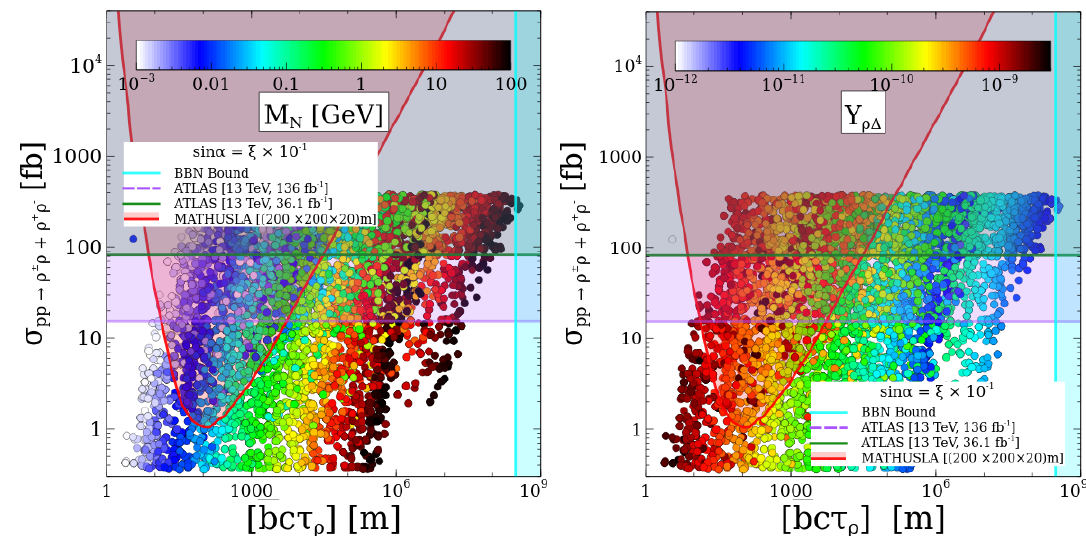
[¯ bcτ ρ ] × ξ 2 ) and production cross and Y for the N ρ ∆